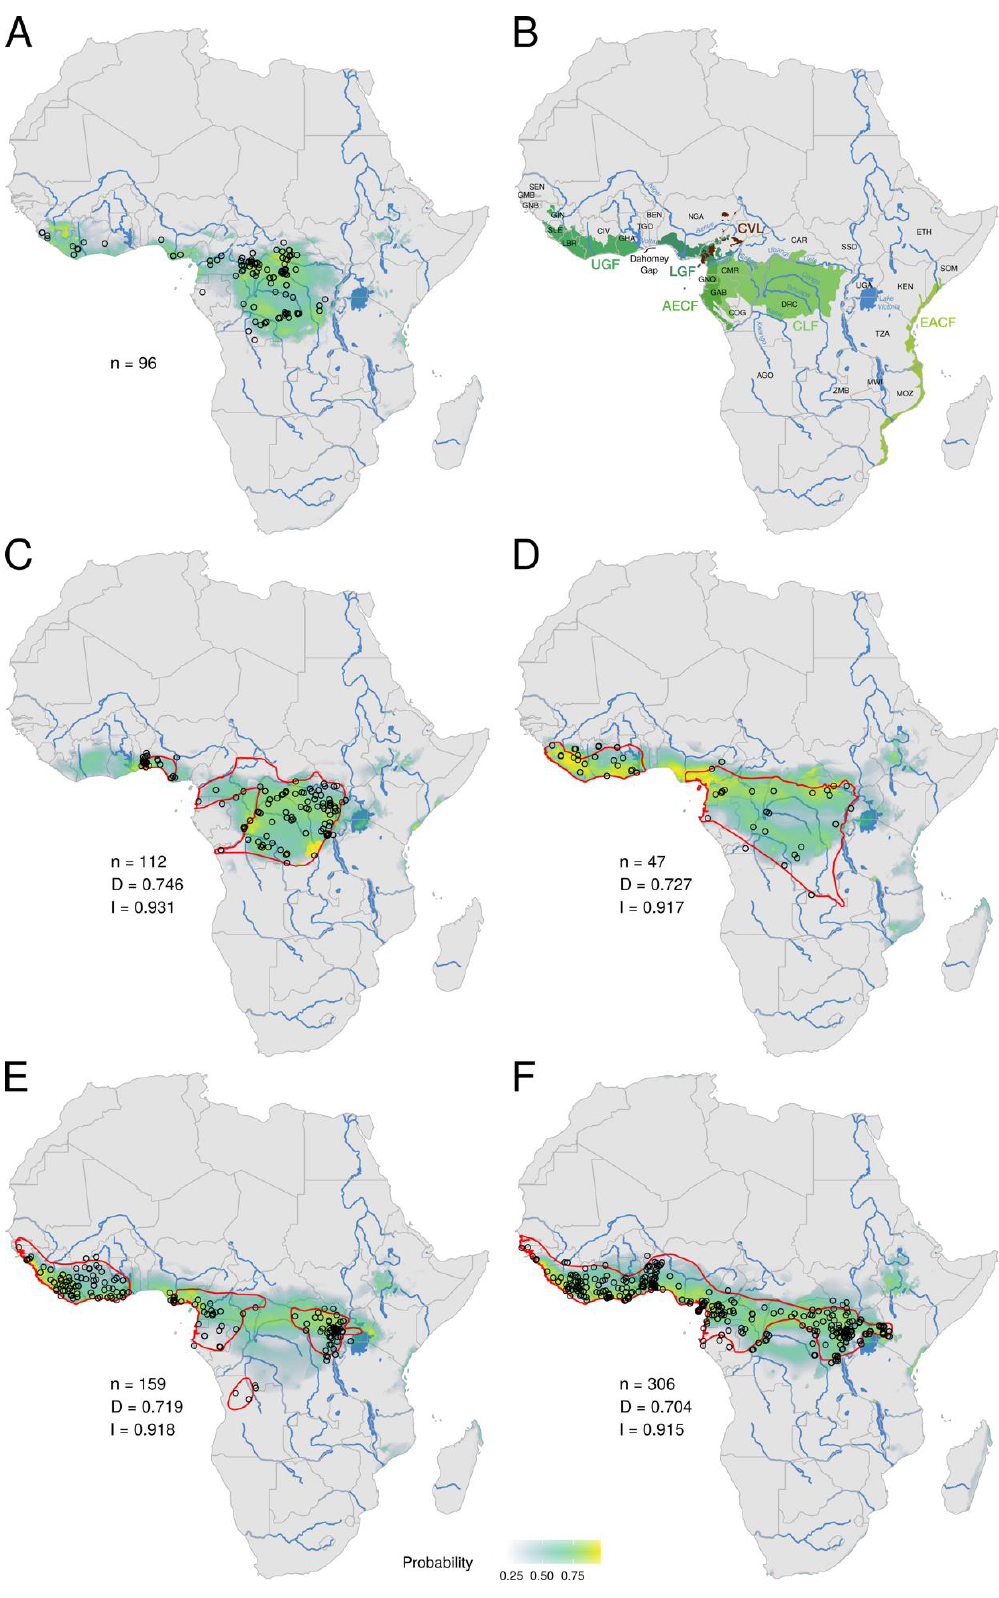
Figure 1. Ecological niches of Monkeypox virus ( A ) and the four mammal species showing the best overlap with it: Funisciurus anerythrus ( C ), Graphiurus lorraineus ( D ), Funisciurus pyrropus ( E ), and Heliosciurus rufobrachium ( F ). Black circles indicate localities used to build the distribution model. The probabilities of occurrence ( p ) are highlighted using different colours: blue grey for probabilities